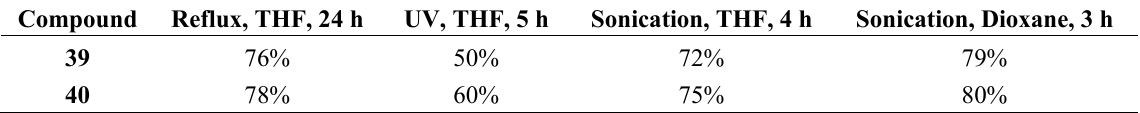
Table 1. Comparative results for the click thiol-ene